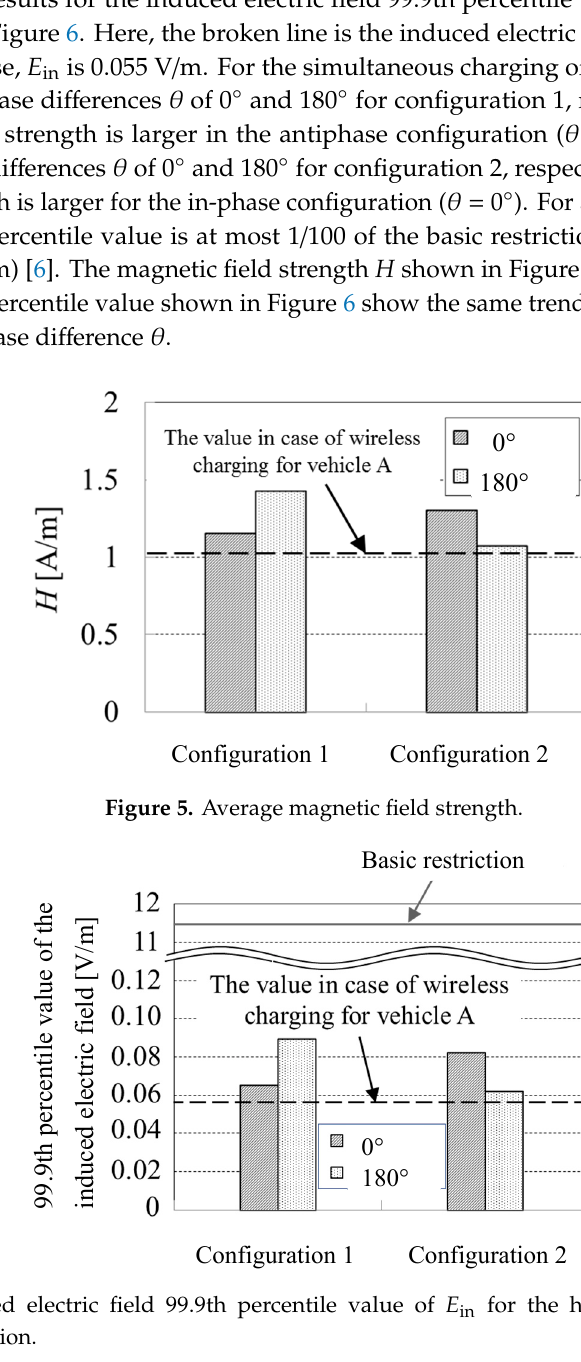
Figure 4. Distribution of leakage magnetic field in x-y place at z = 120 mm for ( a ) only vehicle A being charged and ( b ) both vehicles being charged.